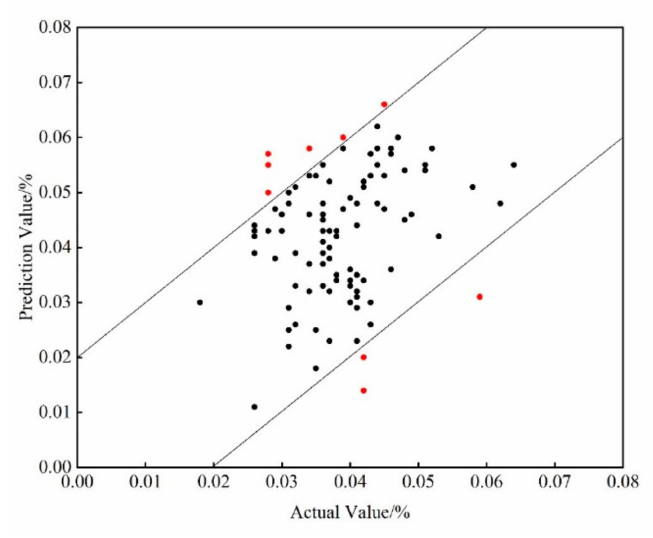
Figure 13. Prediction results of model (m = 4).